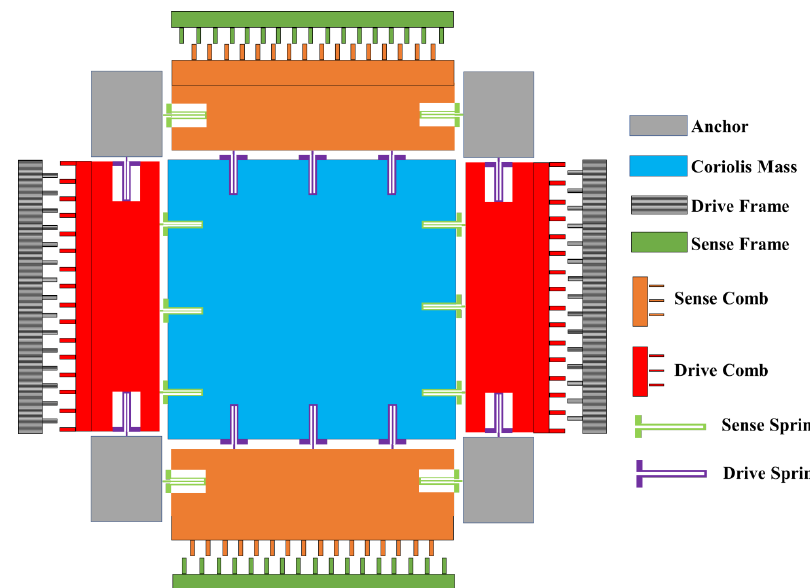
Figure 1. The structure of the MEMS gyroscope.